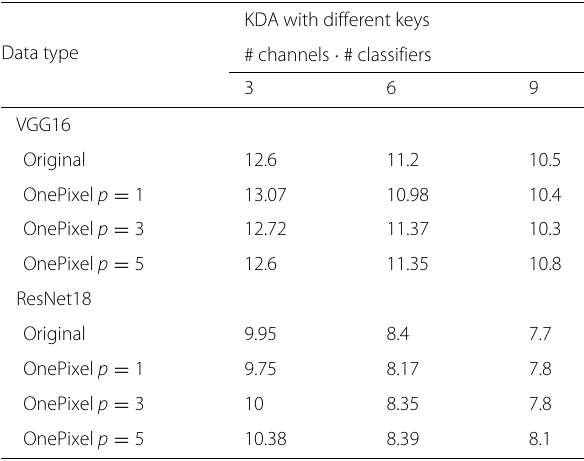
Table 3 Classification error (%) on the first 1000 test samples (CIFAR-10) for the gray-box OnePixel transferability attacks from a multi-channel model to a multi-channel model under different